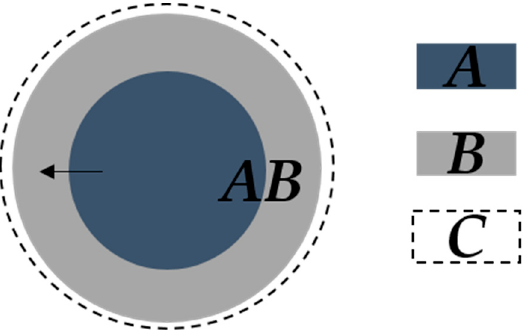
Figure 1. Schematic of a solid-gas reaction, i.e., A (s) B (s) + C (g). AB is the reactant-product interface.